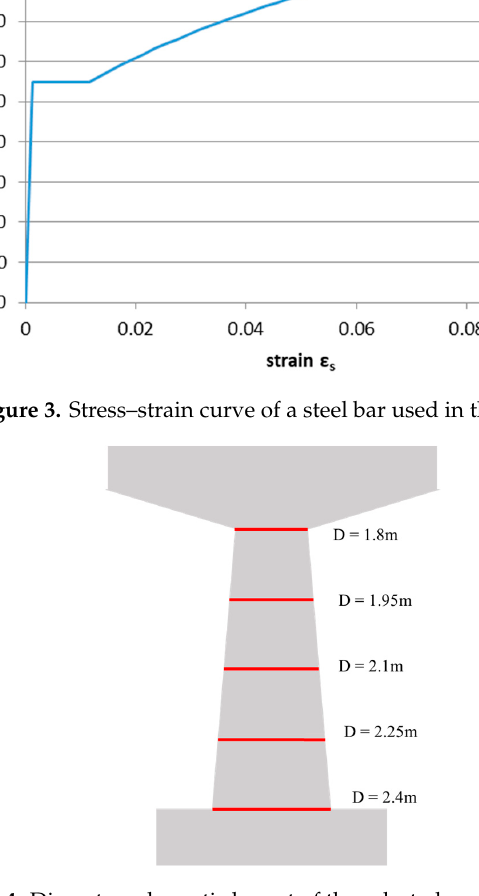
Figure 4. Diameter schematic layout of the selected sectional profile.